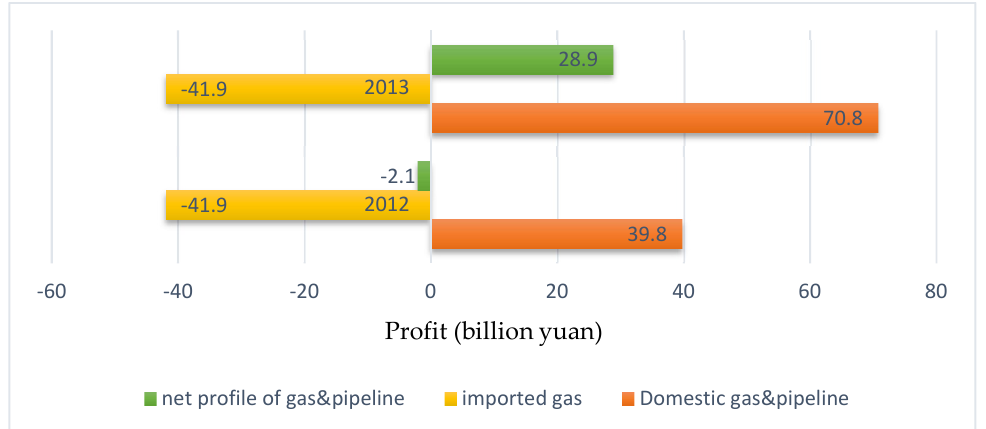
Figure 14. Income, expenditure and profits of PetroChina’s gas and pipeline business in 2012 and 2013. Data source Sinopec (2014).